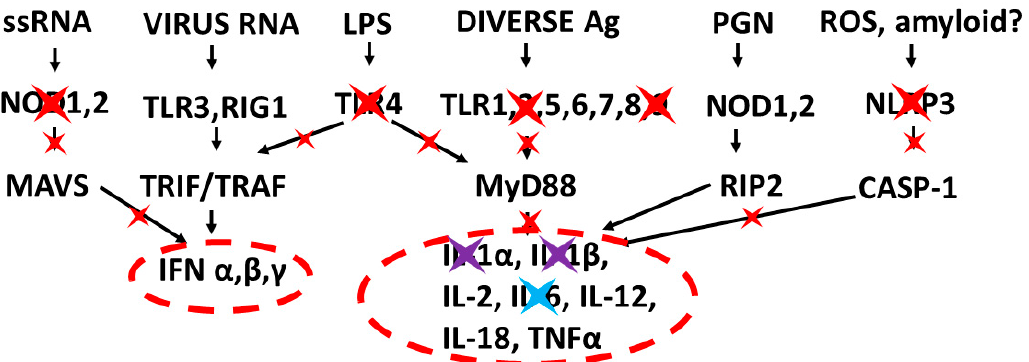
Figure 12. Figure 1 adapted to illustrate the effects of Anakinra, an IL-1 receptor blocker (purple stars), and Tocilizumab and Sarilumab, IL-6 receptor blockers (blue star) that only antagonize one or two cytokines compared with the effects of melatonin (red stars), which downregulates NOD2, TLR2, TLR4, TLR9 and NLRP3, resulting in decreases in the production of all major cytokines (circled in red).